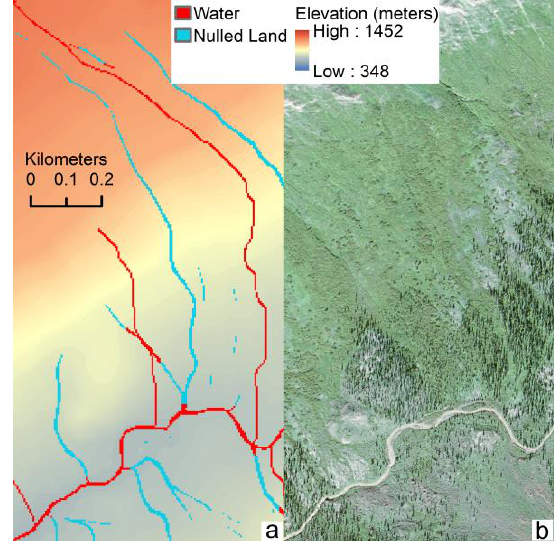
Figure 6. (a) Section of a masked reference dataset with nulled water values that are excluded from accuracy assessment, and (b) Maxar 0.5-m resolution satellite image data of the same